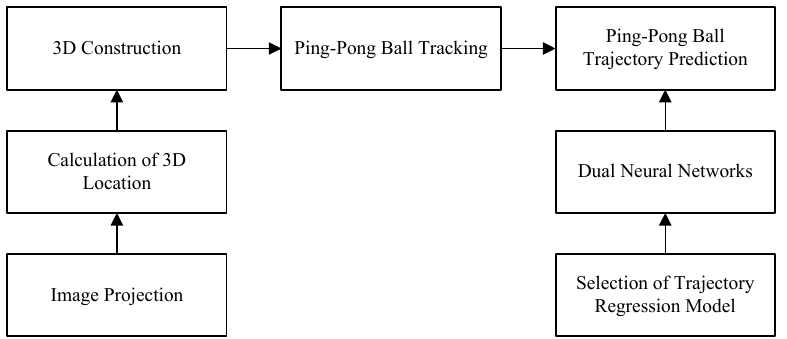
Figure 1. Flow of the proposed